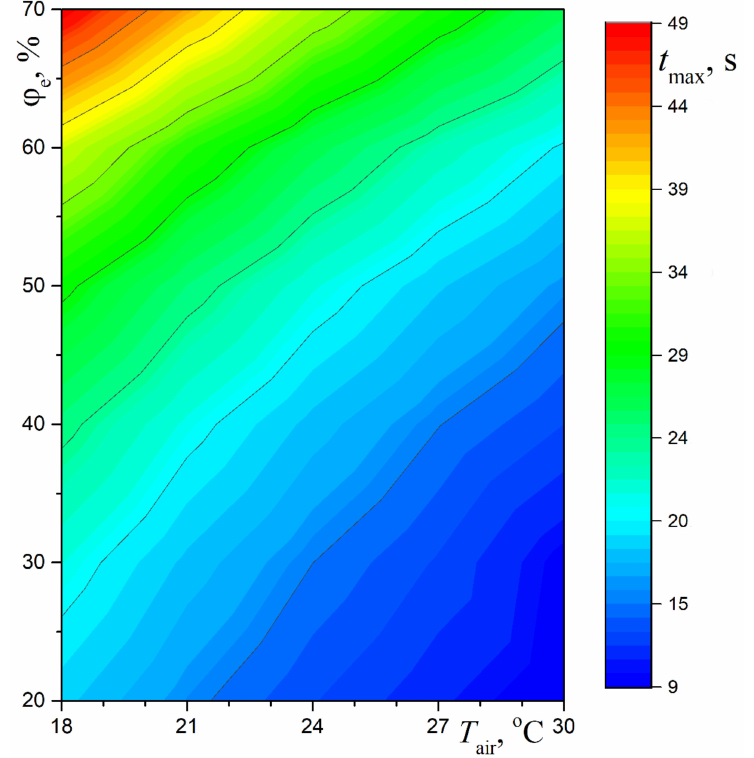
Figure 4. The maximum residence time of levitating microdroplets which may contain